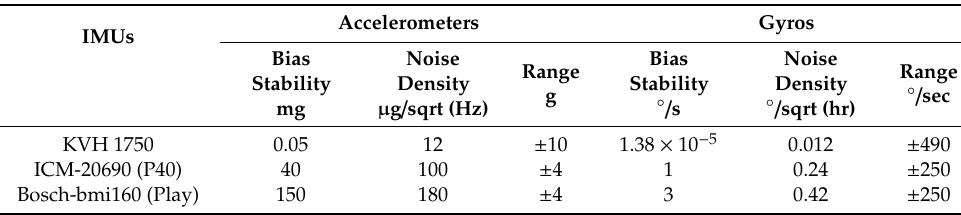
Table 1. The specifications of the IMUs used in the test [13–15].